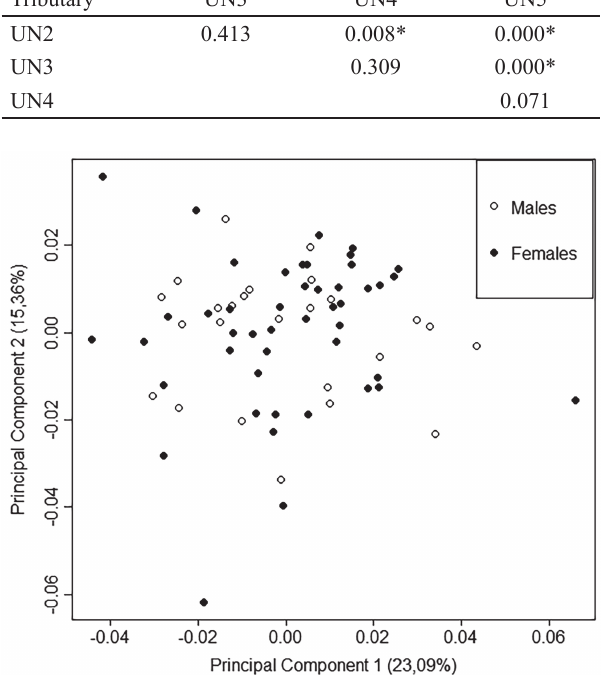
Fig. 3. Scatterplot of principal components analysis examining differences in body shape, categorized by sex. There is no evidence of body-shape related to sexual dimorphism; N=72.